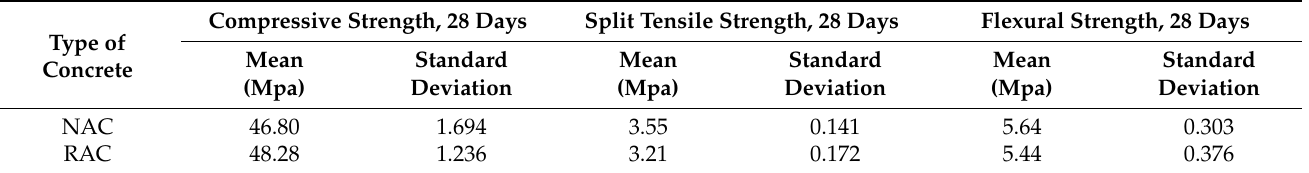
Table 4. Mechanical properties of concrete. Table 3. Matrix proportions of different mixes.